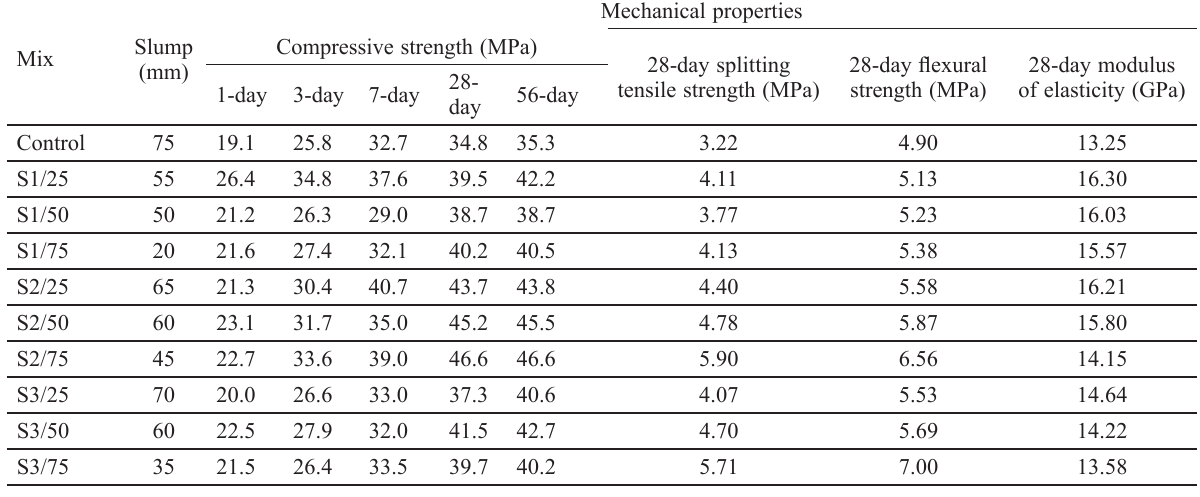
Table 4. Fresh and mechanical properties of OPSC